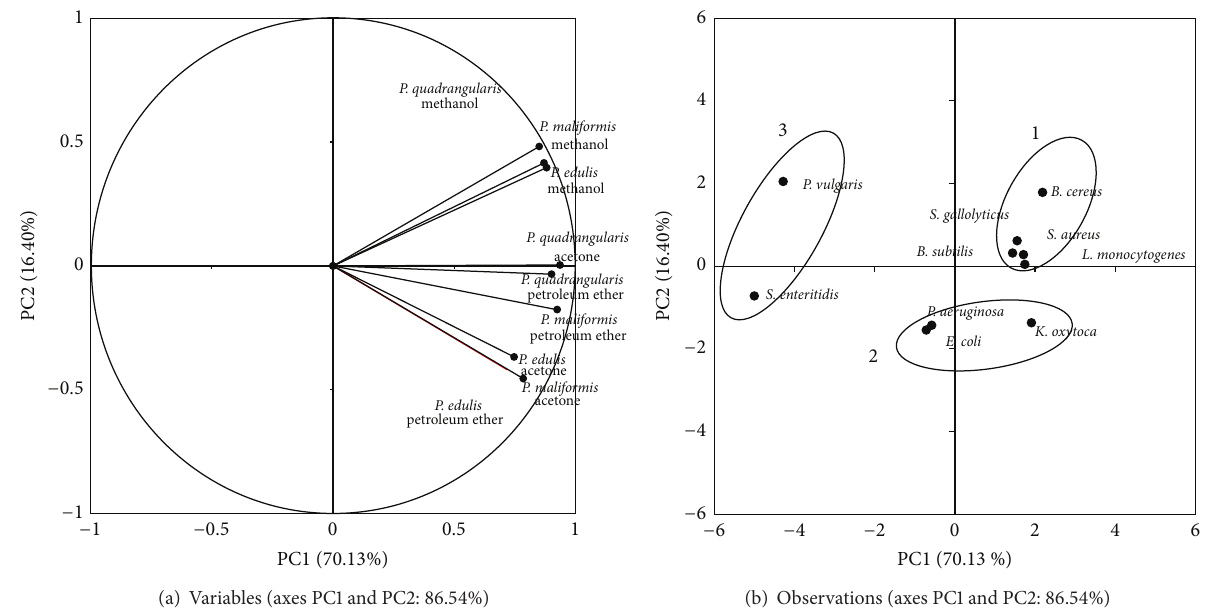
(b) Observations (axes PC1 and PC2: 86.54%) Figure 1: (a) Plot of the variables tested against pathogenic microbes for leaves extracts. Percentages in parentheses represent the variation of each component. (b) Positions of the PC scores of the 10 microorganisms according to PC1 and